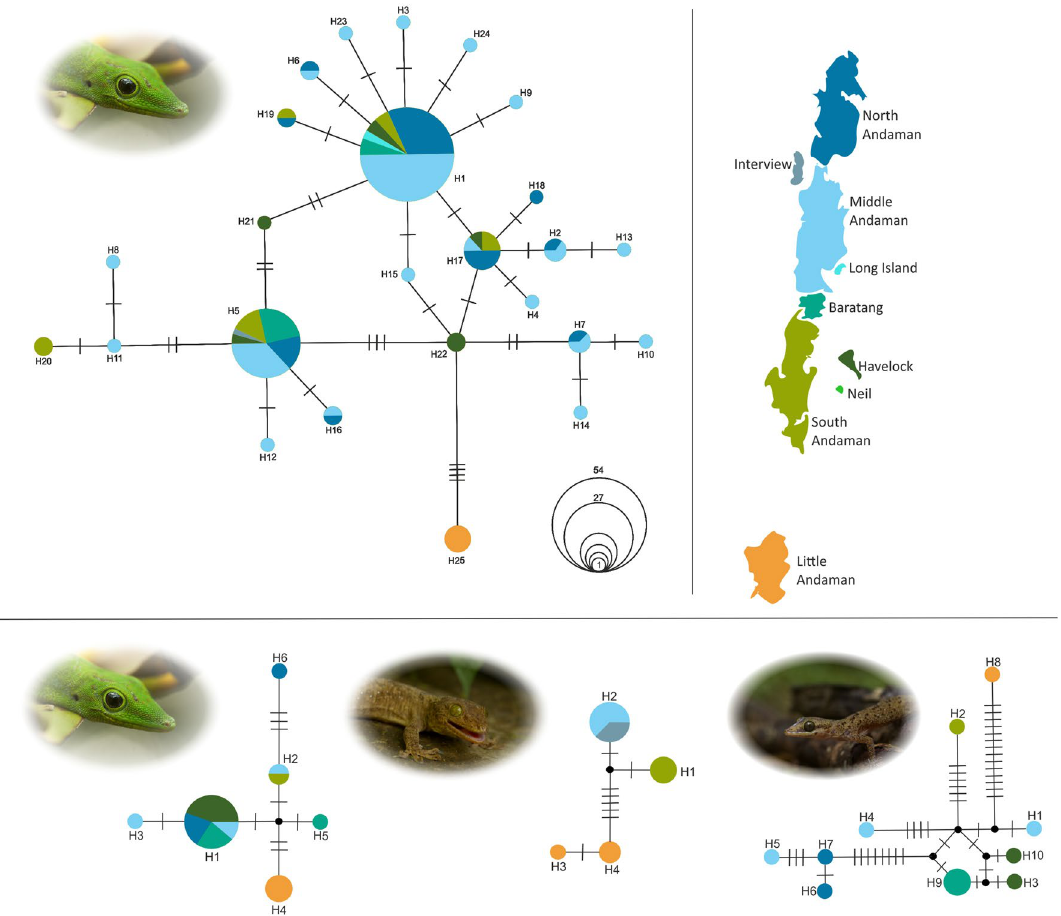
Figure 5. Top: Haplotype network from DNA sequences of 314 bp of the mitochondrial COI gene for 123 individuals of the Andaman day gecko ( Phelsuma andamanensis) sampled across the Andaman Islands. Haplotypes are colour coded based on the island on which an individual was sampled; the size of the circles in the haplotype network corresponds to haplotype frequencies whose scale is provided in uncoloured circles; each cross bar in the network represents a mutation and black points correspond to median vectors generated during the construction of the Median-Joining haplotype network. Bottom: Haplotype networks from DNA sequences of the mitochondrial 16SrRNA from three species of gecko endemic to the Andaman Islands. left: the Andaman day gecko ( Phelsuma andamanensis ); centre: the Andaman bent toed gecko ( Cyrtodactylus rubidus ); right: the Andaman giant gecko ( Gekko verreauxi ). Composite figure produced in CorelDraw Home & Student, X7 (https ://www.corel draw.com), map created for graphical representation only and is not to be